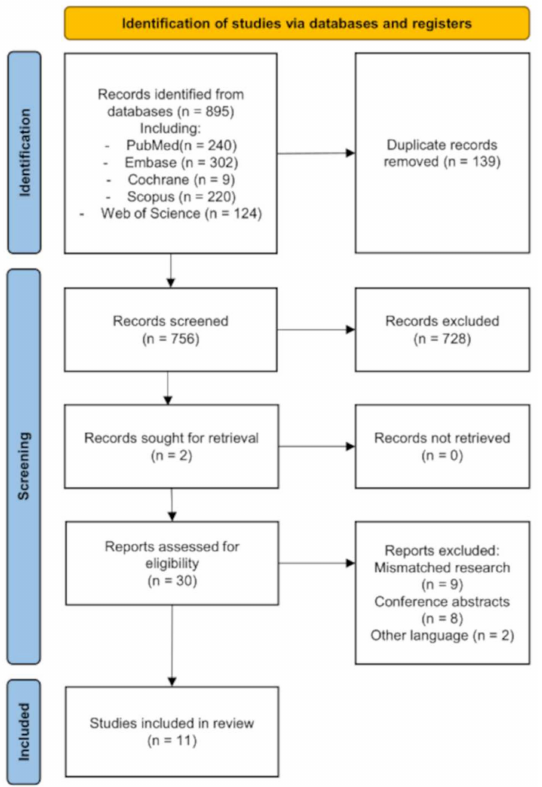
Figure 1. Flow diagram of the systematic review search.